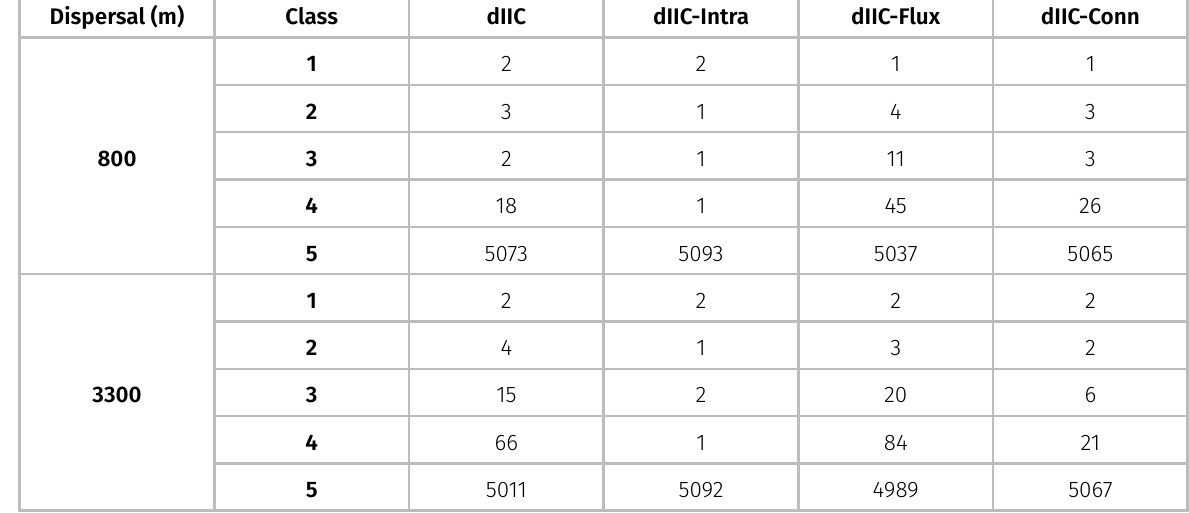
Table I. Quantity of fragments for the Belém area of endemism as classified by the dIICindex 800 and 3300 meters. Dispersal (m)